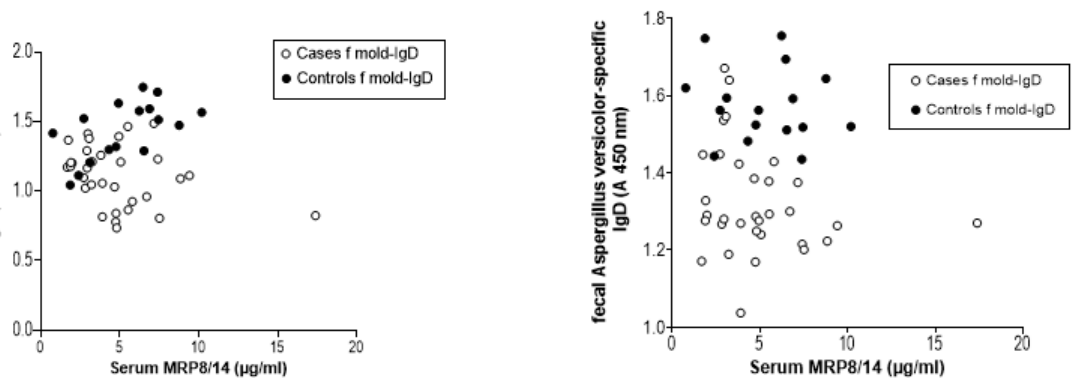
Figure 8. Impact of the protein levels in the coating of the microtiter wells for ROC assays. All the results are from IgD responses of fecal samples against Aspergillus versicolor when plotted against the serum inflammation marker MRP8/14. The amount of the coating extract was studied by conducting the assay either in 1000 or 333 µg/mL of A. versicolor extract.